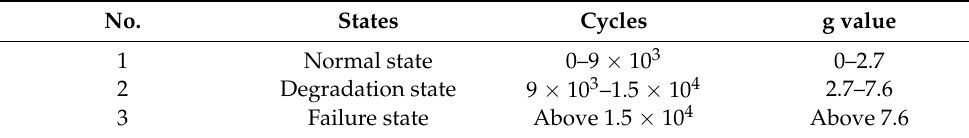
Figure 8. Parameter g versus cycle number. Table 1. Working cycles corresponding to degradation states.